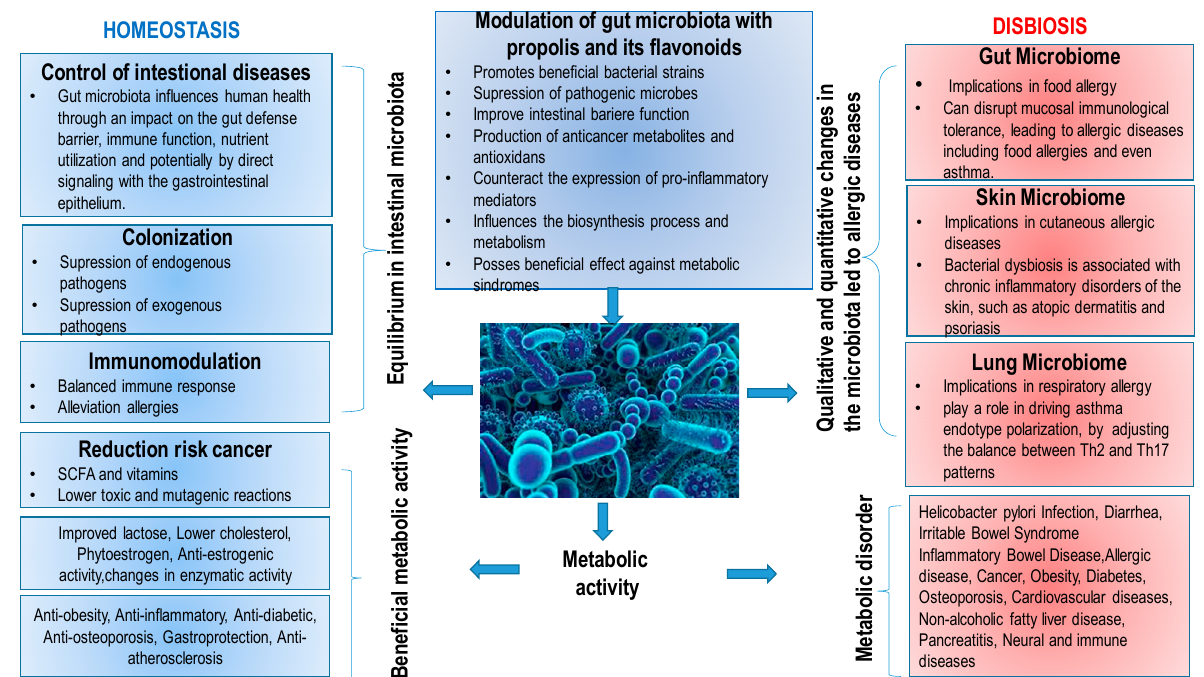
Figure 6. The main benefit of propolis and its flavonoids as prebiotics and their potential mechanism of action on the intestinal microbiota under physiological and pathological conditions, such as allergic diseases and metabolic disorders.